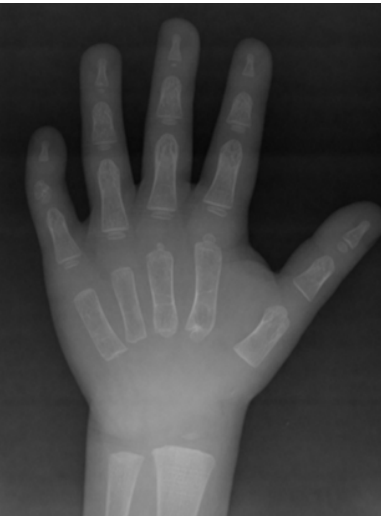
Figure 1. Radiologic image of right hand of patient 1. Note the absence of ossification of the carpal bones, in particular dysmorphism of the base of the second metacarpus and of the intermediate phalanx of the 5th finger.